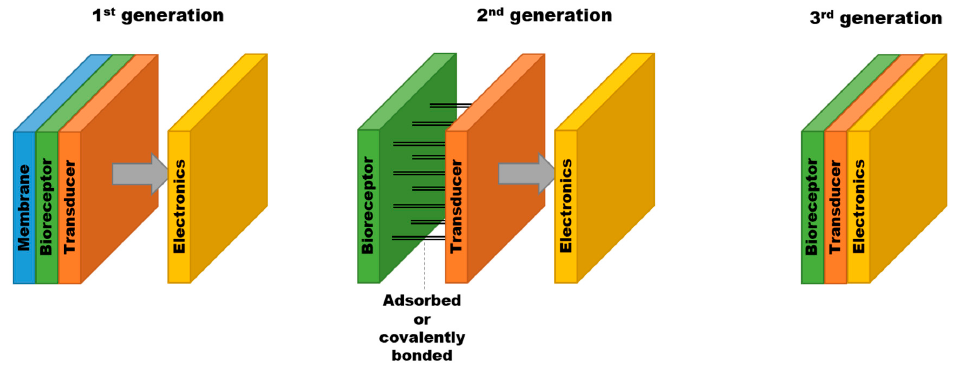
Figure 3. Three generations of biosensors.